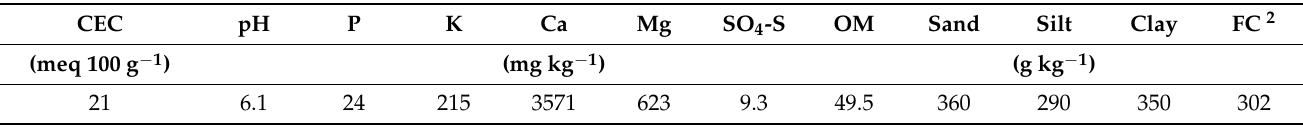
Table 1. Selected mean soil chemical and physical properties 1 in the top 15 cm. Soil test values for individual years and drainage conditions are similar to the overall